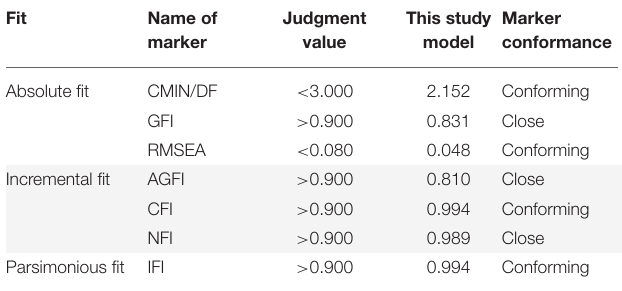
TABLE 3 | Overall Study Model Fit Pointer Analysis ( n =